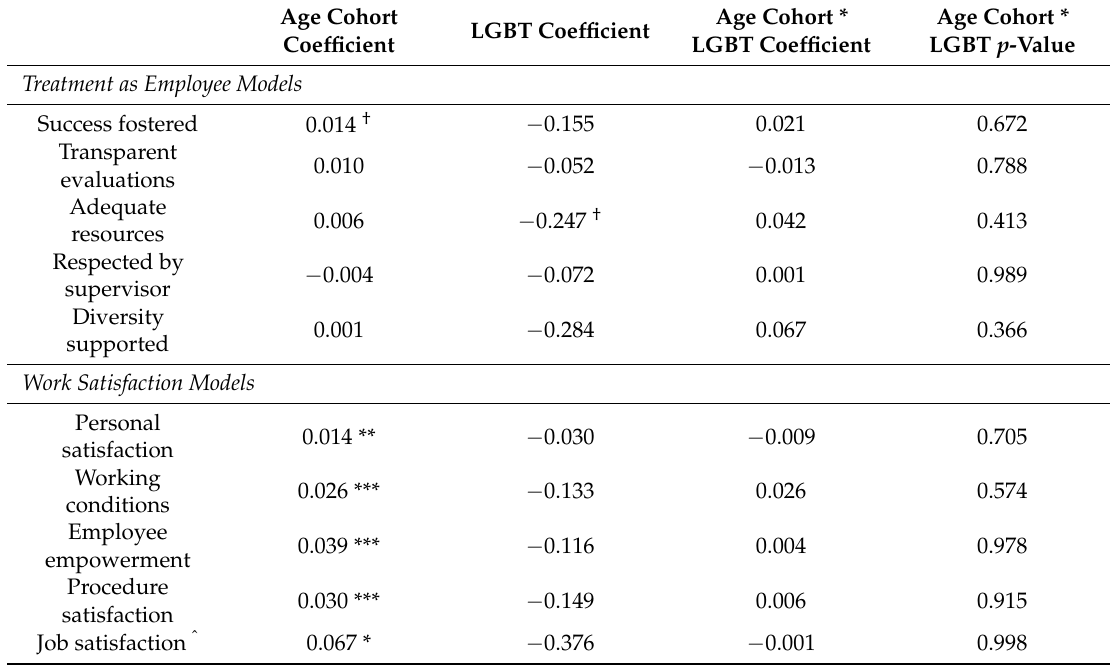
Table 5. OLS and Ordered Logistic Regression Models Predicting Workplace Experience Measures with LGBT X Age Cohort Interaction Term (N = 37,219).